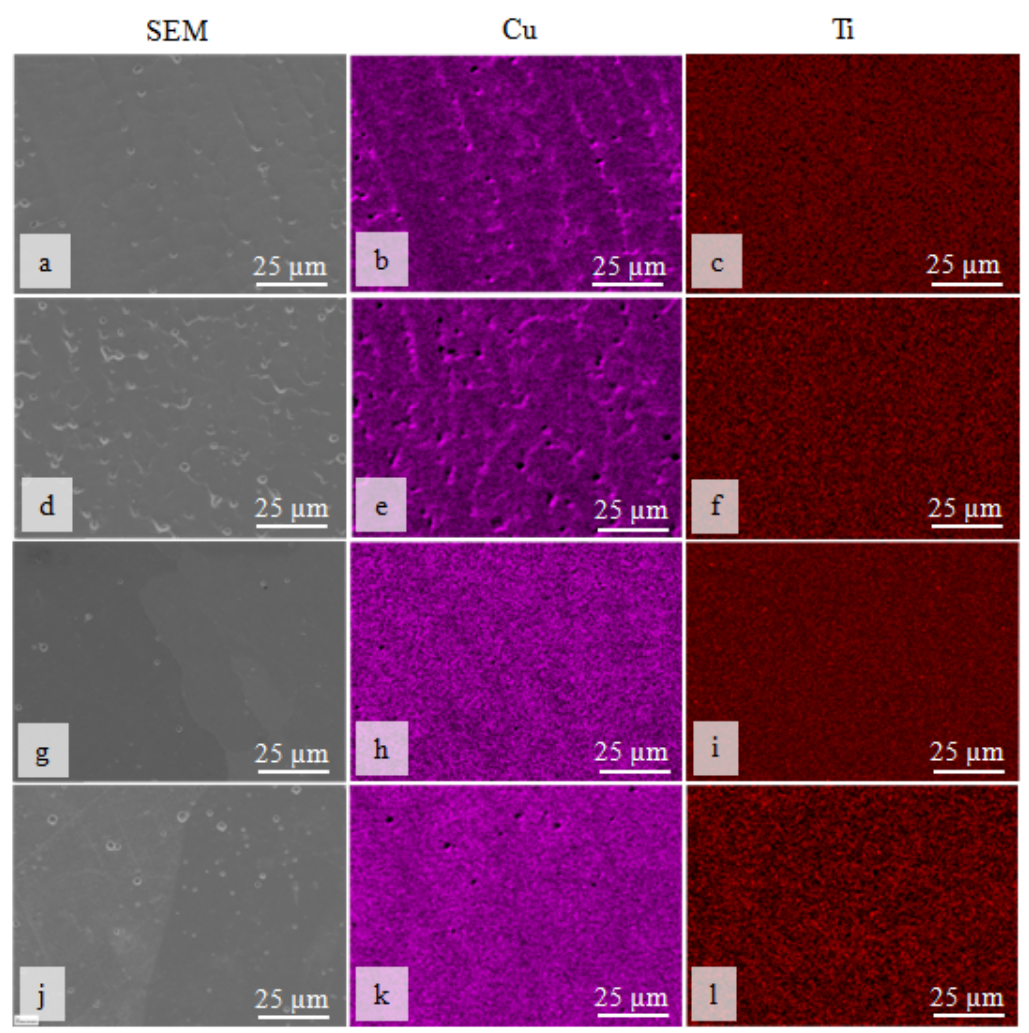
Figure 4. Representative SEM images of the microstructure in ( a , g ) Monel K500 and ( d , j ) FM60, and energy dispersive X-ray spectroscopy (EDS) maps showing Cu segregation in as-weld ( b ) Monel K500 and ( e ) FM60, absence of Cu segregation in annealed ( h ) Monel K500 and ( k ) FM60, absence of Ti segregation in as-weld ( c ) Monel K500 and ( f ) FM60 and absence of Ti segregation in annealed ( i ) Monel K500 and ( l ) FM60 (travel speed of 500 mm/min).